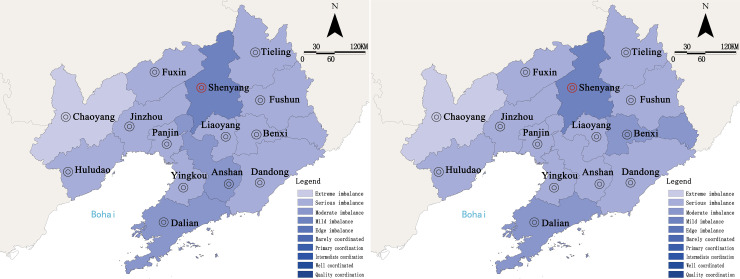
Spatial distribution of the degree of coupling and coordination of urban agglomerations in Liaoning Province in 2009 and 2019.a. 2009. b. 2019. (Source of base map: The open source map data service provided by the National Platform for Common GeoSpatial Information Services (https://www.tianditu.gov.cn/)).